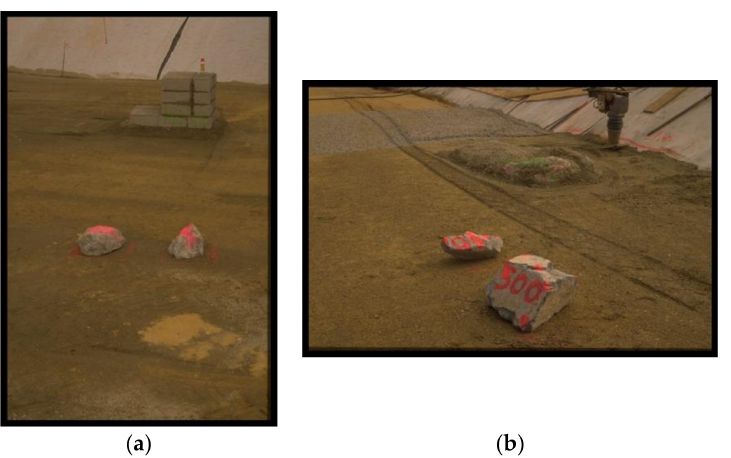
Figure 14. Placement of: ( a ) Isolated blocks and a masonry wall; ( b ) a heap of rocky